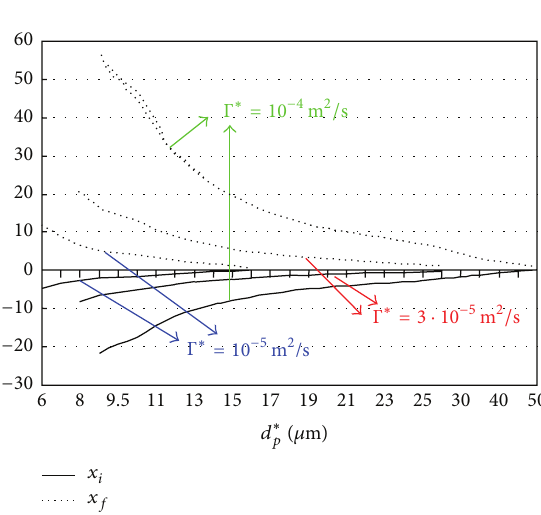
Figure 3: Limits of the mesh of particles inside the trapping region of the vortex as a function of 𝑑 ∗ 𝑝 and Γ ∗